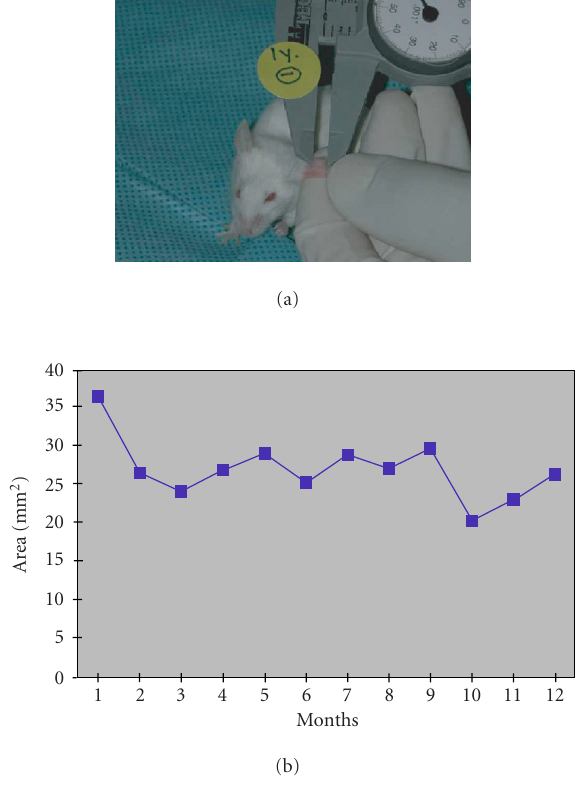
Figure 1. (a) Viability of human neurofibroma xenograft in SCID mouse ear for 12 months after implantation, without therapy with pirfenidone. Human neurofibromas confirmed by frozen section histology were cut in 2 × 2mm pieces and im- planted subcutaneously into the ear of SCID mice. Tumor size was assessed by inspection and direct outside measurement of the two largest perpendicular diameters and area calculation, us- ing a caliper with 0.025 mm accuracy. (b) Neurofibroma xeno- transplants in the ear were stable in size for twelve months after implantation. The line shows an average size of four tumor im- plants in the ears, based on area